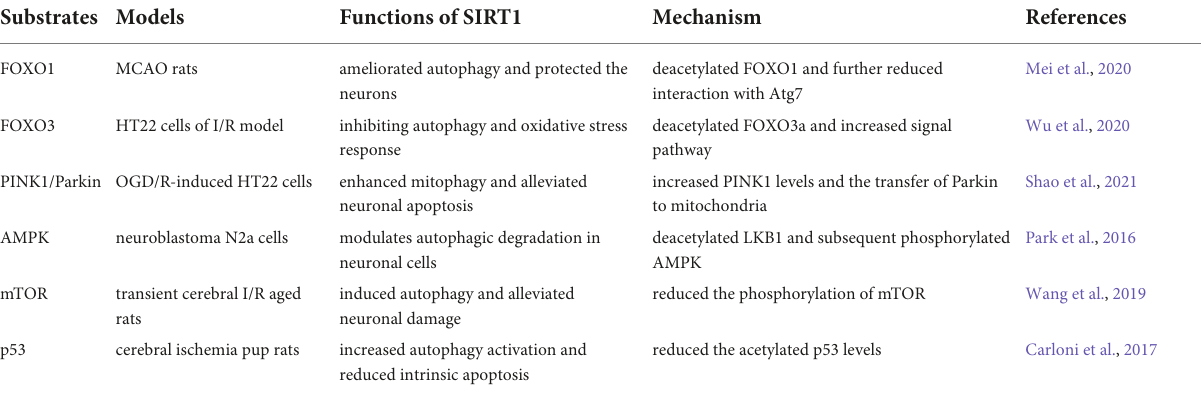
TABLE 1 Targets of silent information regulator 1 (SIRT1) that are modulated during the autophagy process. Substrates